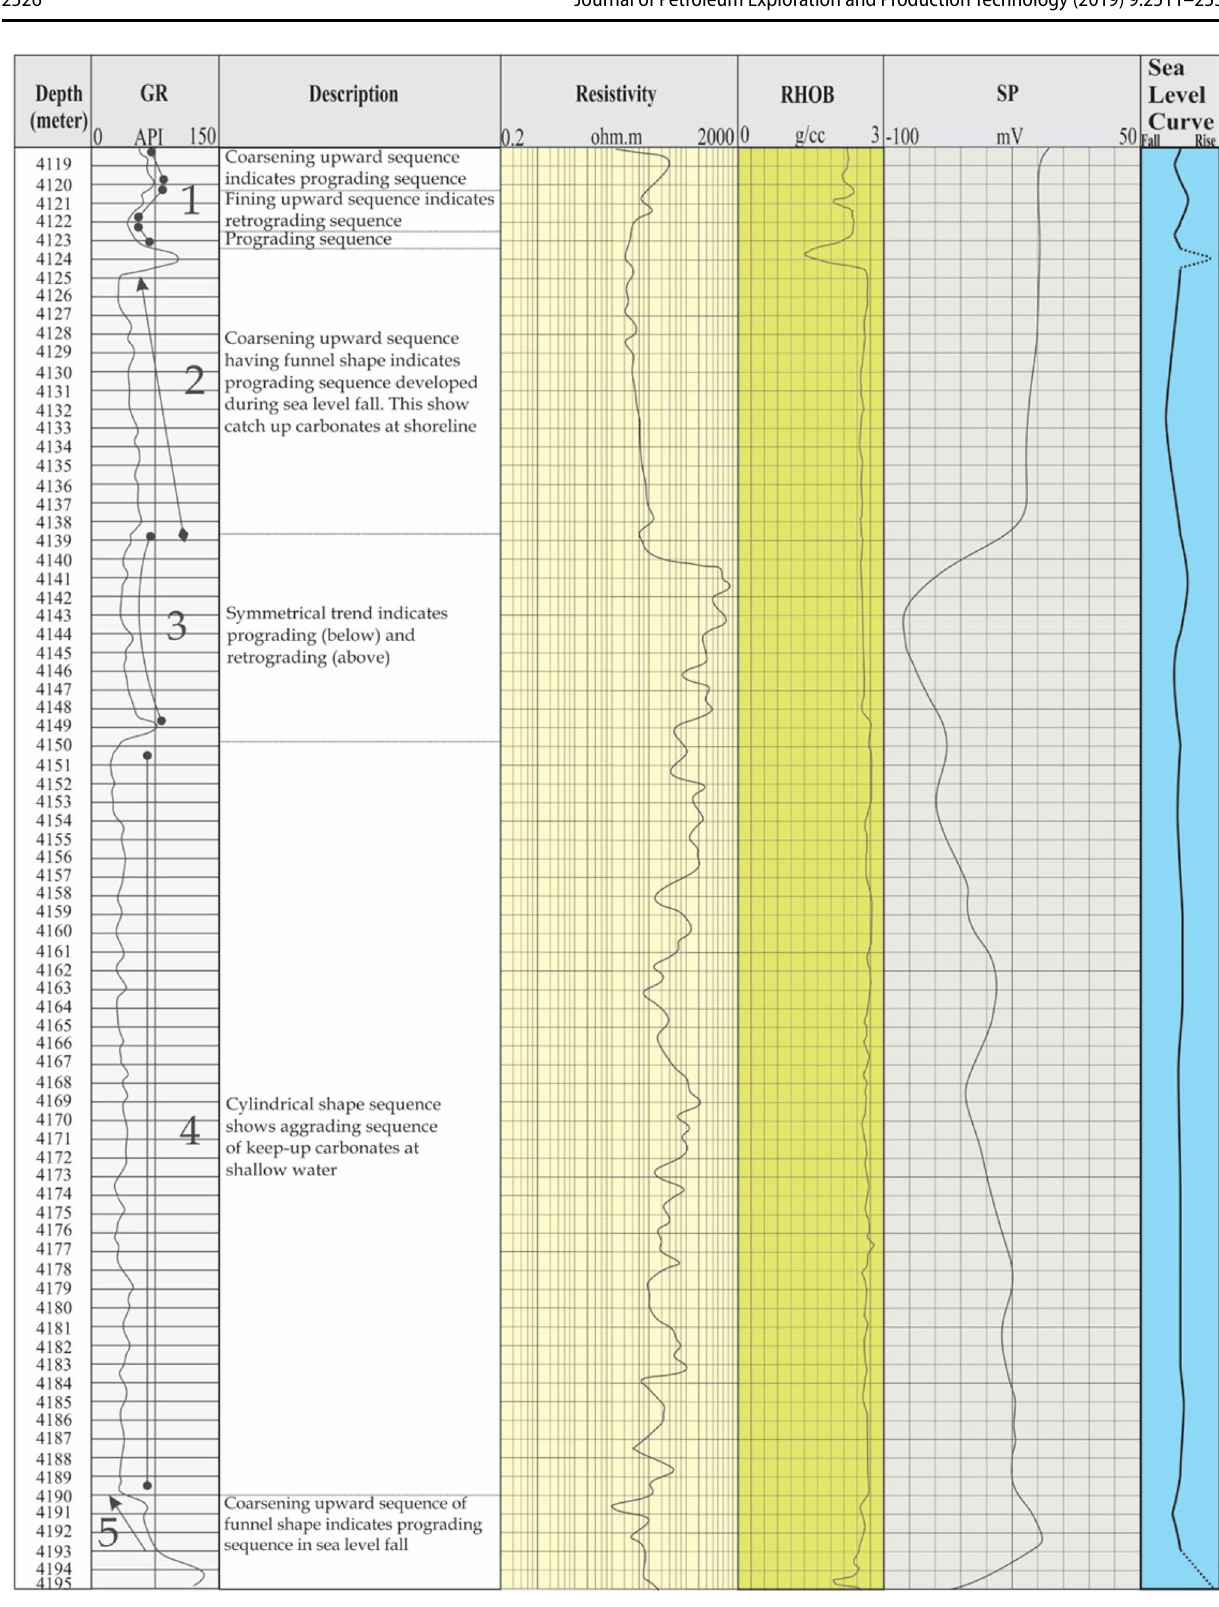
Fig. 20 Log response, depositional facies (electrofacies) and transgressive–regressive (T–R) sequences of the Lockhart Limestone in